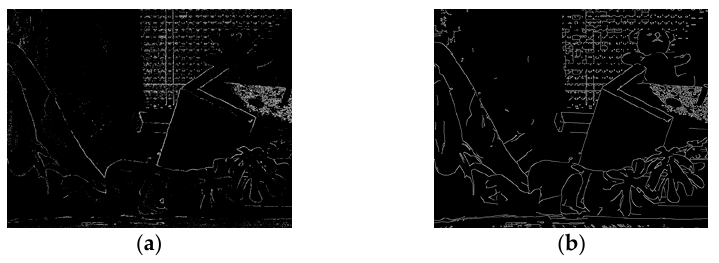
Figure 4. ( a ) High-frequency regions produced by difference of Gaussian (DoG) and ( b ) edge components produced by Canny operator.